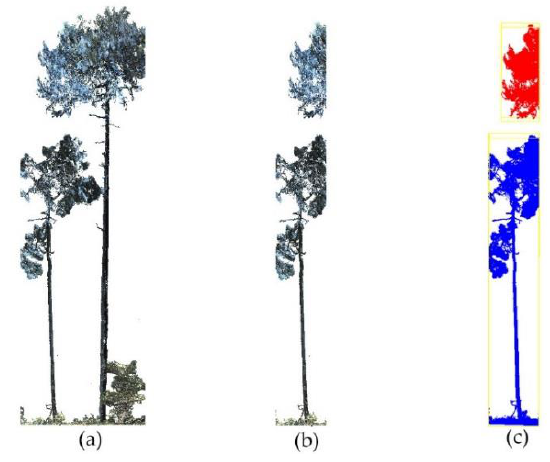
Figure 7. Height extraction of trees in a natural forest. ( a ) Mixture of trees with different heights; ( b ) The height of the highest point of a point cloud may not represent tree height; ( c ) Segmented tree points.